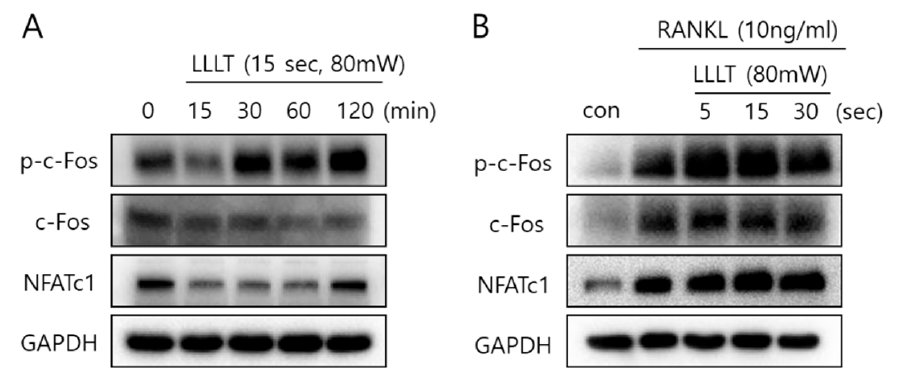
Figure 6. Activation effects of the c-Fos and NFATc1 pathways by LLLT irradiation. ( A ) Only LLLT (15 s) was applied to RAW 264.7 cells, and the change pattern of MAPK was confirmed for 15 to 120 min. ( B ) In the presence of RANKL, LLL was irradiated for 5 to 30 s, and after incubation for 24 h, the expression of c-Fos and NFATc1 was confirmed.